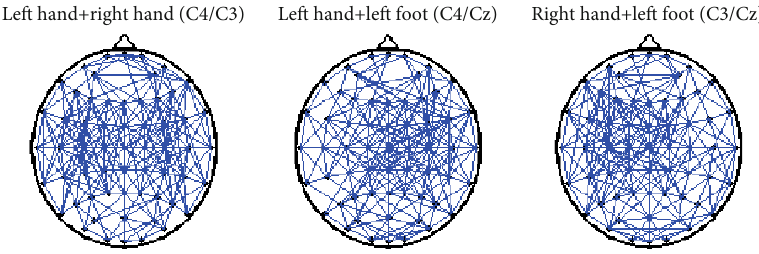
Figure 4: BFN topological structures of compound limb MI.